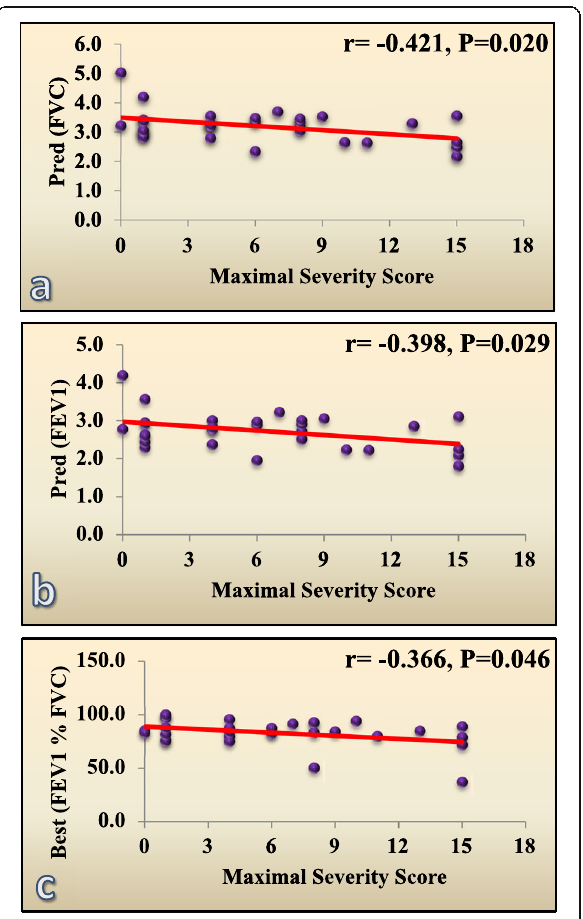
Fig. 10 a Correlation between maximal severity score and predicted (FVC). b Predicted (FEV1). c Best